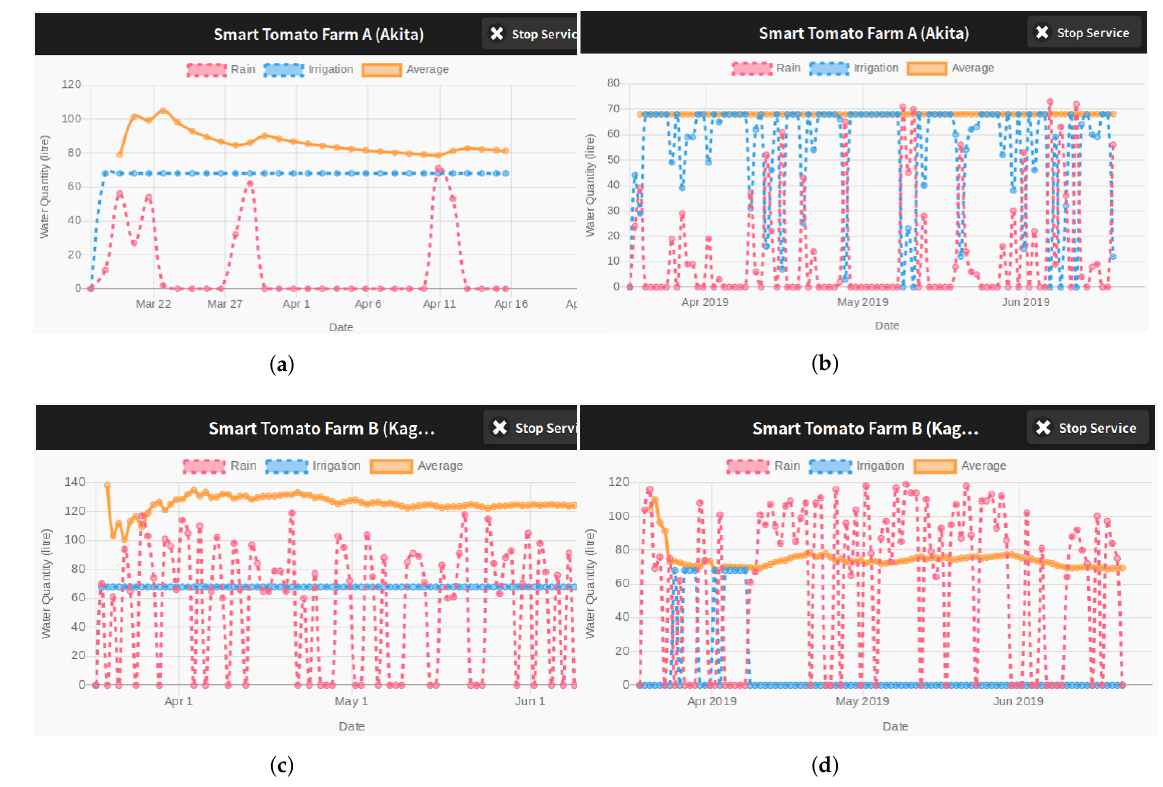
Figure 13. Evaluation on the quality of adaptability for different environments. ( a ) Smart Farm A implemented without Elgar Platform; ( b ) Smart Farm A implemented with Elgar Platform; ( c ) Smart Farm B implemented without Elgar Platform; ( d ) Smart Farm B implemented with Elgar